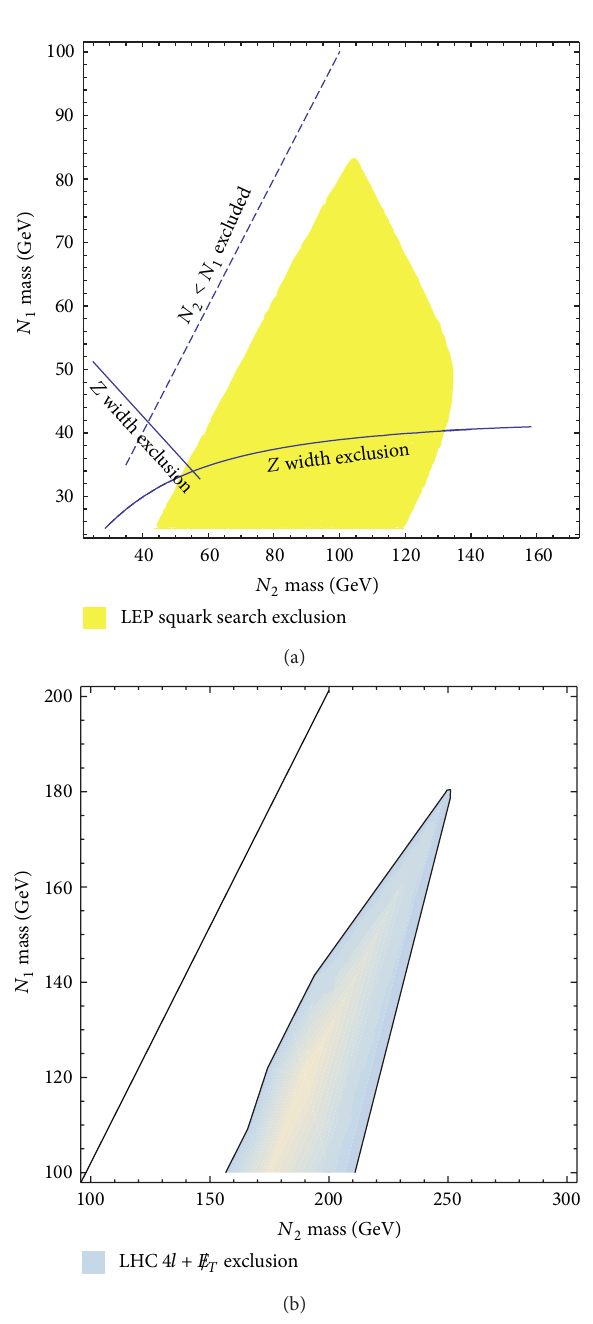
Figure 6: Exclusion limits in the (𝑁 2 , 𝑁 1 ) mass plane at 95% confidence limits. (a) Likely exclusion limit from the LEP 2 squark search and 𝑍 -pole constraints. (b) Exclusion region for an LHC −1 integrated luminosity. Figures from 4𝑙 + (cid:2) 𝐸 𝑇 search, for 30 fb